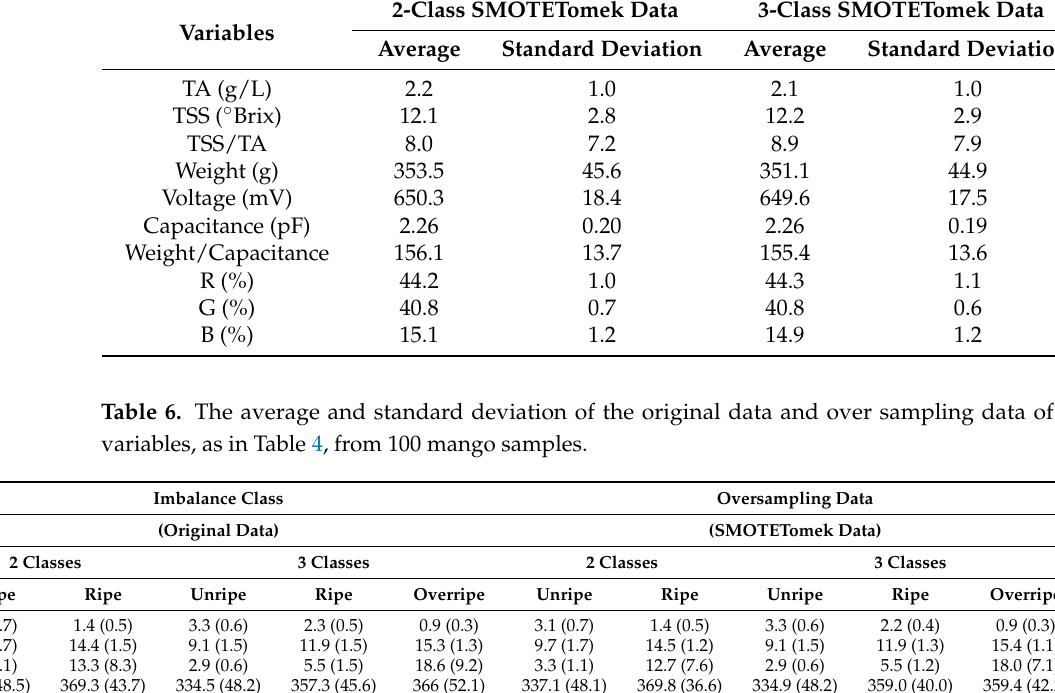
Table 5. The average and standard deviation of the oversampling data of 10 variables, the same as those given in Table 4, from 100 mango samples.